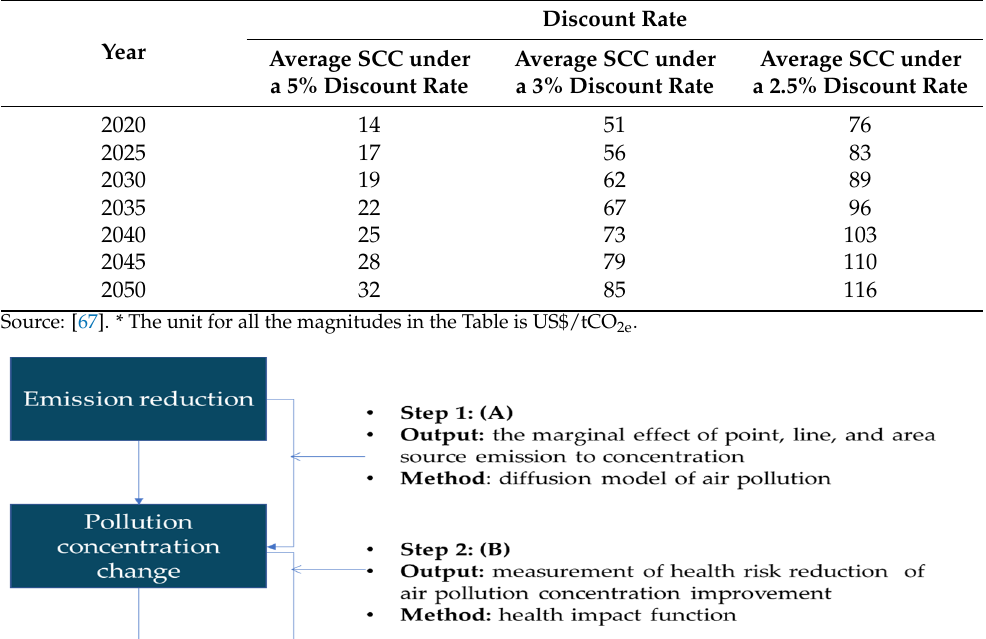
Table 1. The social cost of carbon under different discount rates estimated by the US Interagency Working Group on the social cost of carbon *.